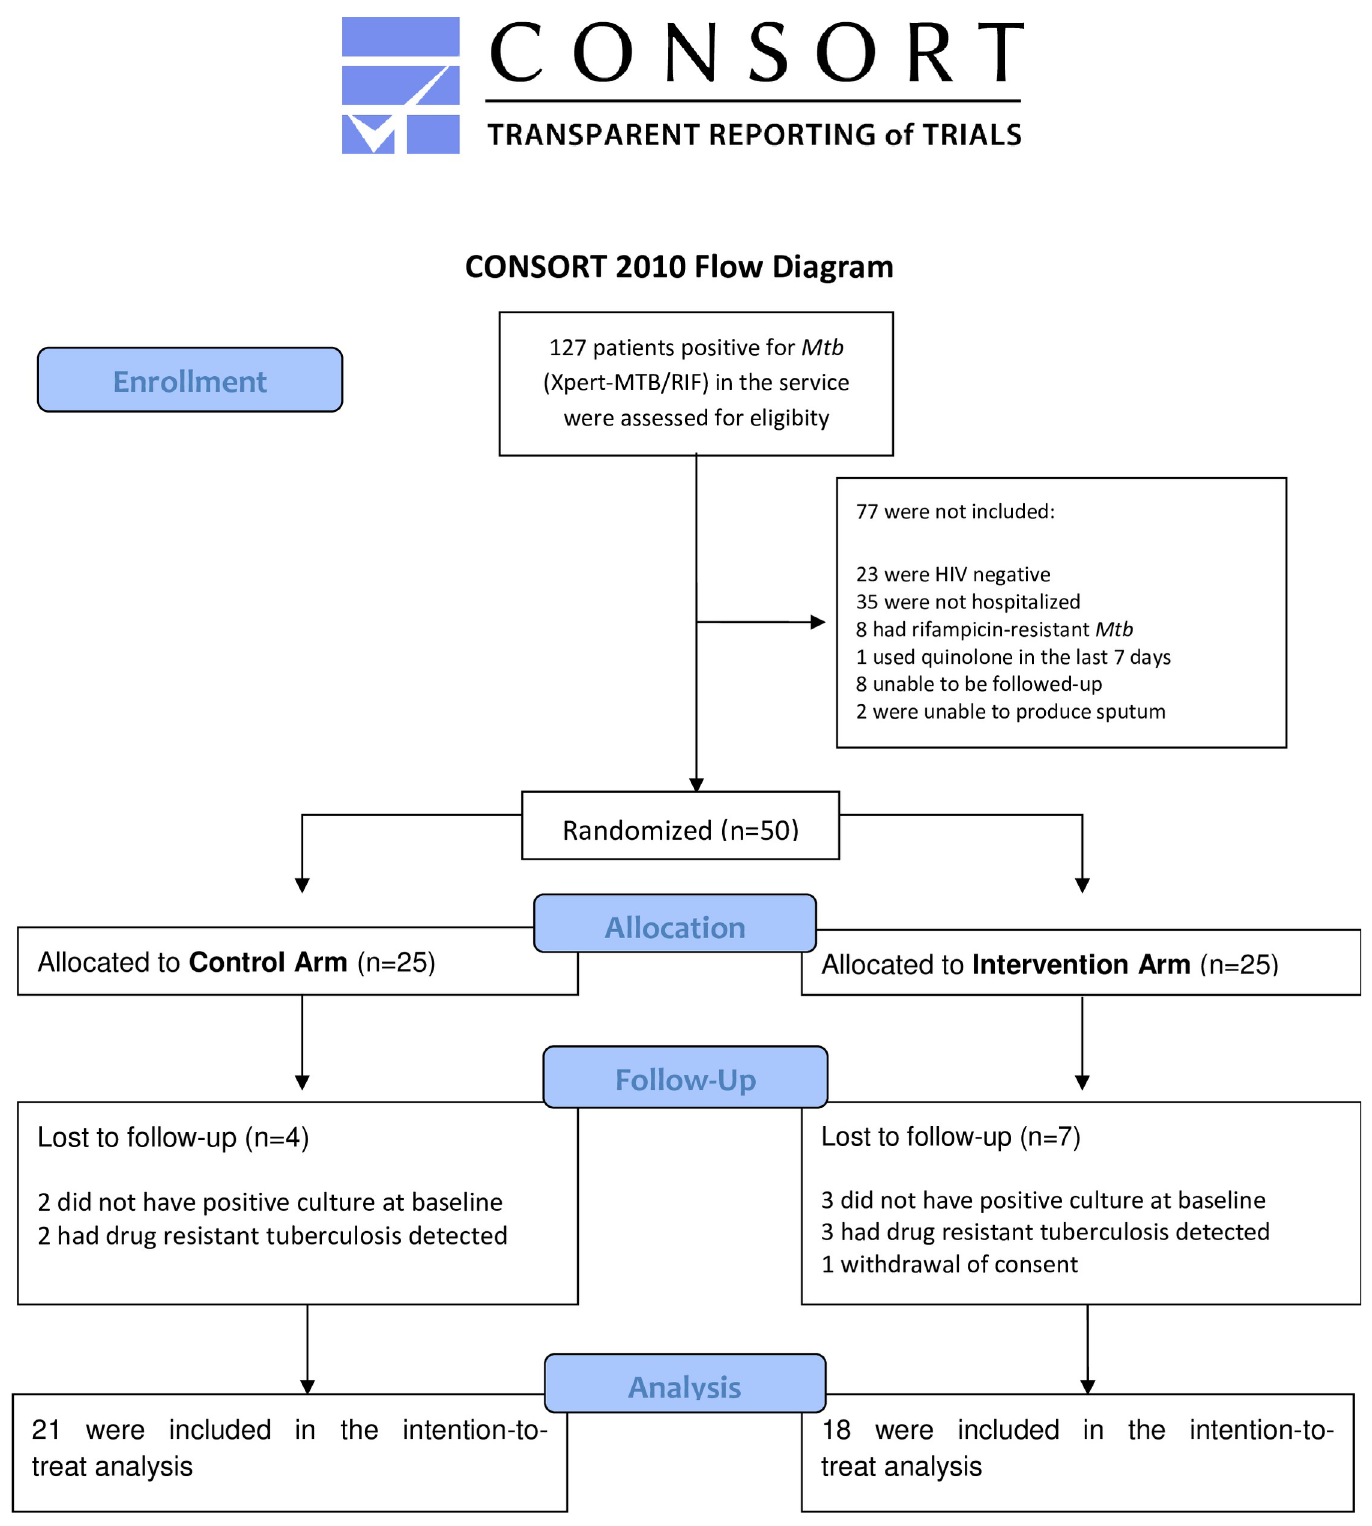
Fig 1. Flowchart of eligible, randomized and enrolled patients in the study.